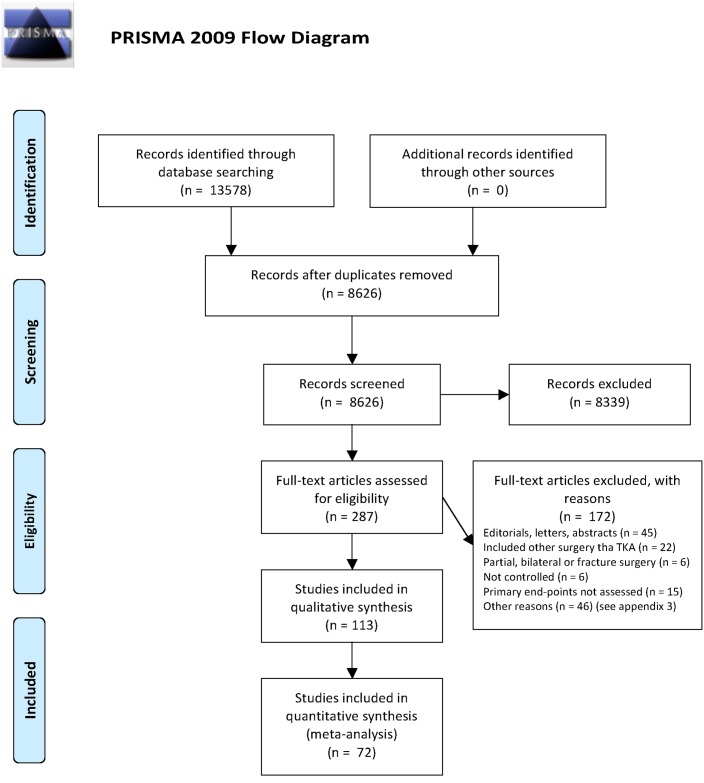
Flow chart of trial selection.From: Moher D, Liberati A, Tetzlaff J, Altman DG, The PRISMA Group (2009). Preferred Reporting Items for Systematic Reviews and Meta-Analyses: The PRISMA Statement. PLoS Med 6(7): e1000097. doi:10.1371/journal.pmed1000097. For more information, visit www.prisma-statement.org.